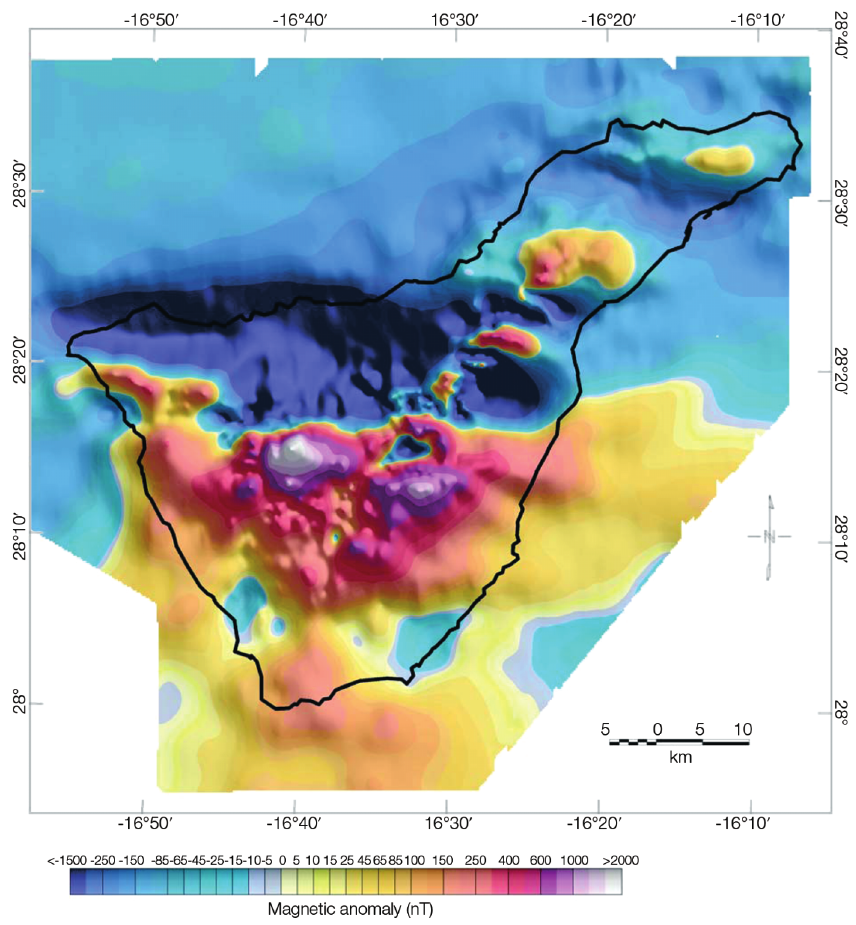
Fig. 5. Colour shaded relief magnetic anomaly map (total intensity) of Tenerife Island with colour intervals ad- justed to the amplitude content of the whole grid. Latitude and longitude are north and west from Greenwich re-